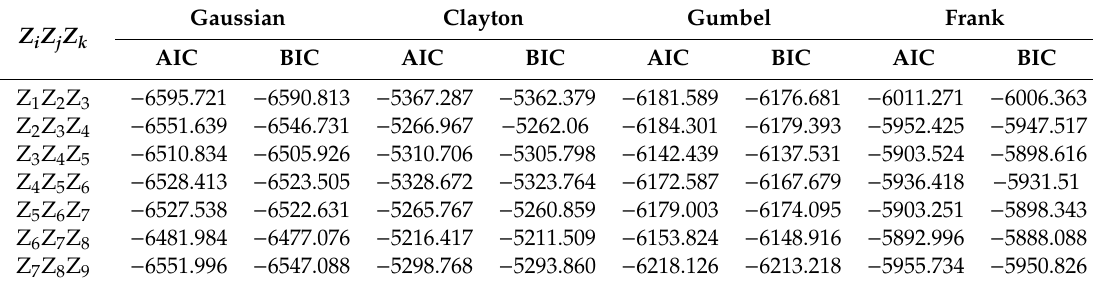
Table 12. The AIC and BIC values for the candidate copulas.